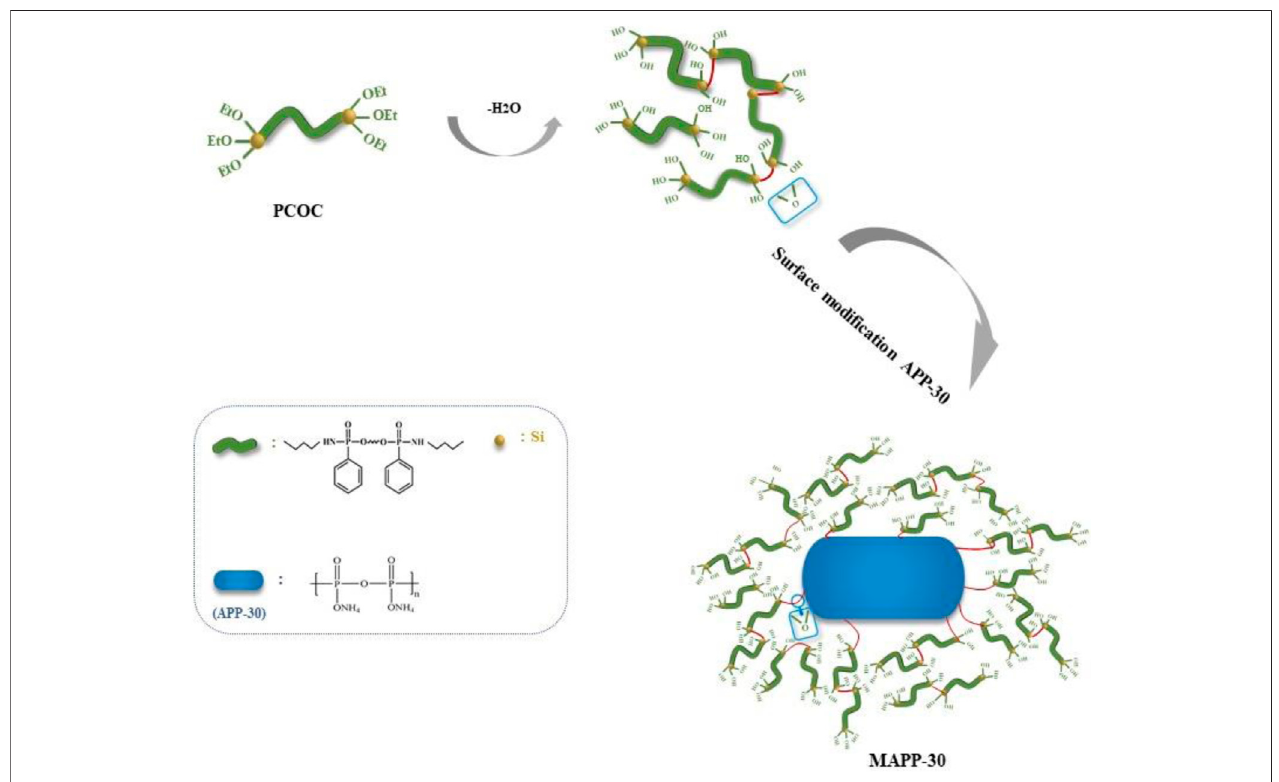
FIGURE 2 | Surface modi fi cation of APP-30.